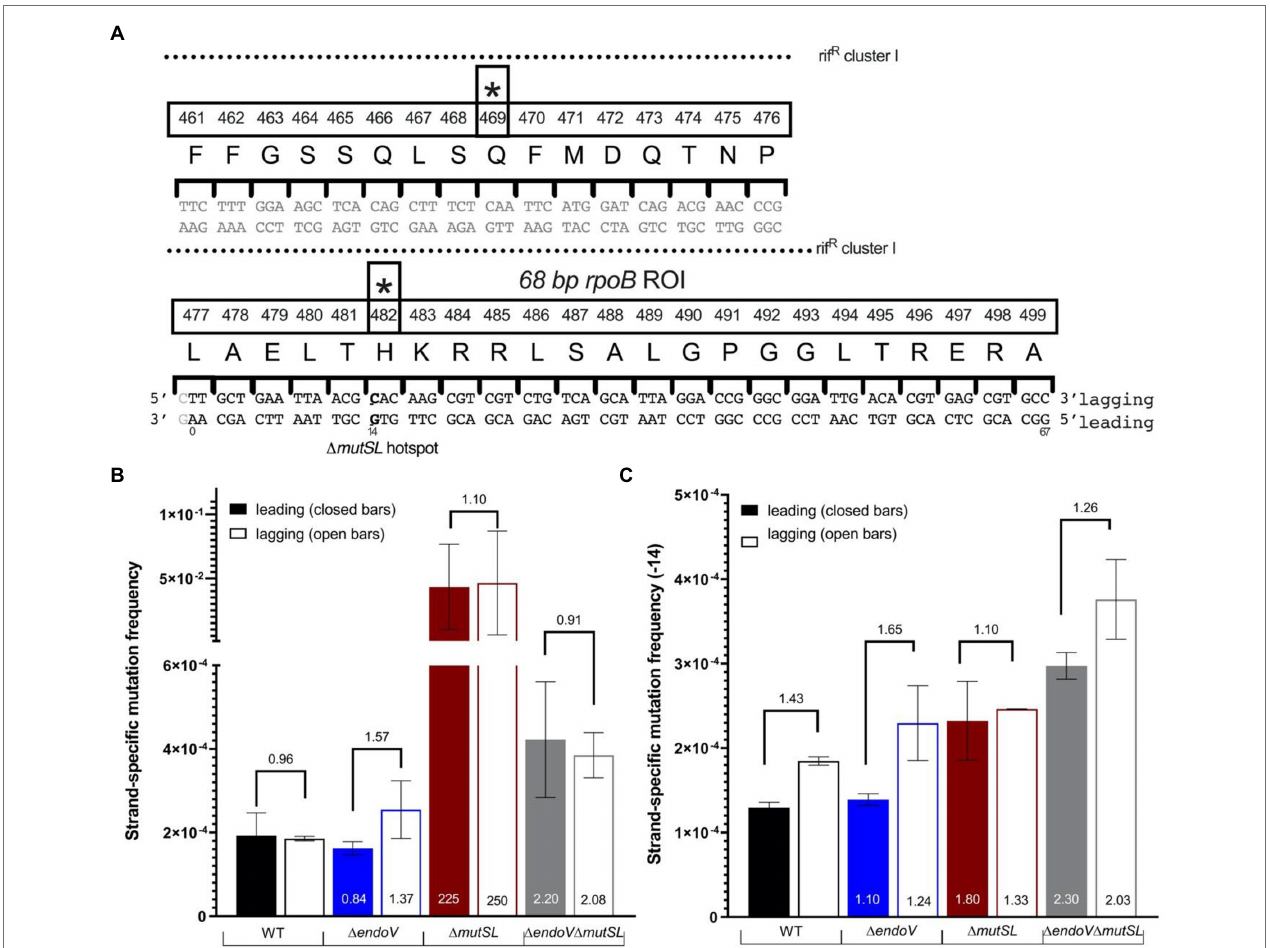
FIGURE 2 | Maximum Depth Sequencing (MDS) of B. subtilis strains with distinct genotypes. (A) Schematic and sequence of the 68-bp rpoB ROI selected for MDS. The diagram depicts the overlap with the Rif R cluster I (dotted lines), amino acid position, and the stars denote the two characterized mutagenic hotspots that confer Rif R in B. subtilis . (B) Strand-specific mutation frequencies for the strains indicated. (C) Strand-specific mutation frequencies excluding position 14 corresponding to the first position of codon 482. The bars represent the average strand-specific frequency of two biological replicates. Each strand-specific frequency for each replicate was calculated by taking the total of all the changes in the ROI/important nodes. Error bars are SEM. Numbers on top of the graph denote the fold change increase or decrease of the lagging strand compared to the leading (example Δ endoV lagging/ Δ endoV leading) while the numbers at the bottom represent the fold change increase or decrease of each strand compared to the WT (example Δ endoV leading/WT